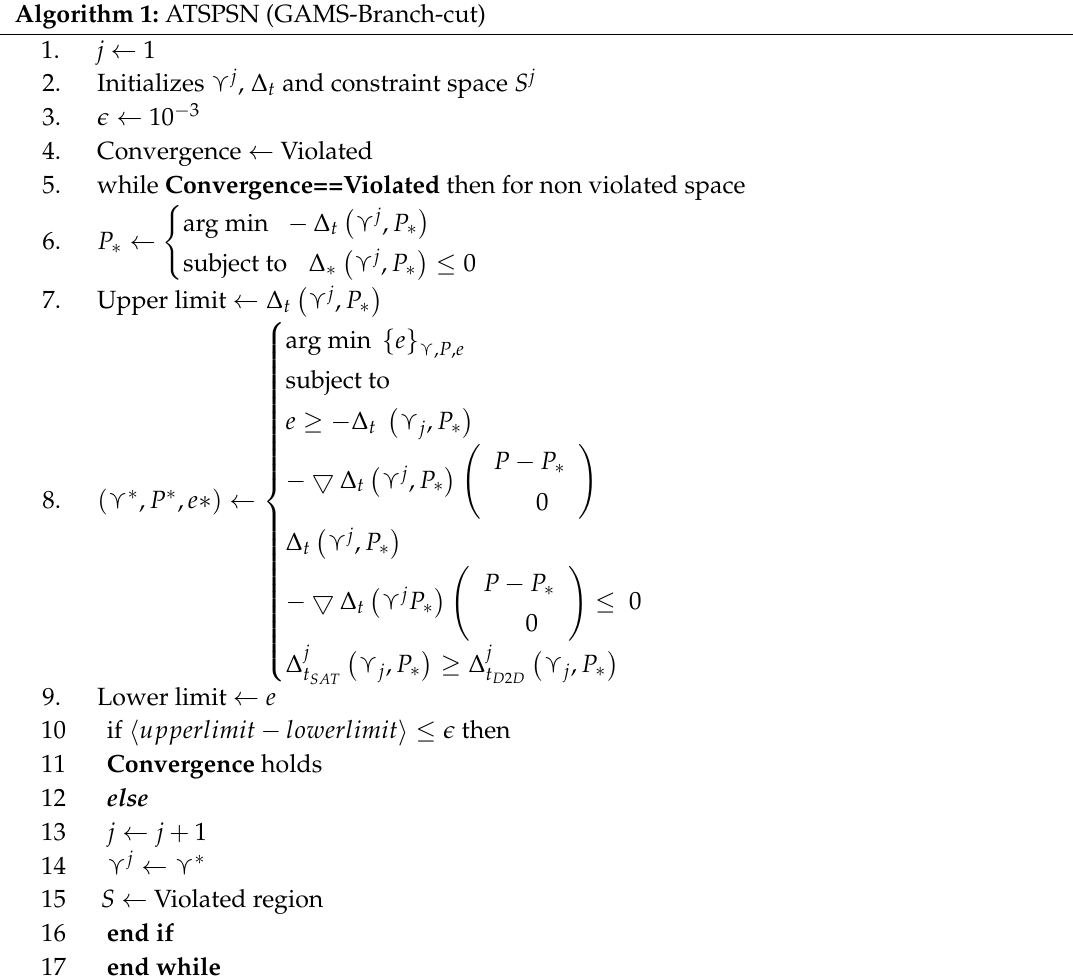
Algorithm 1: ATSPSN